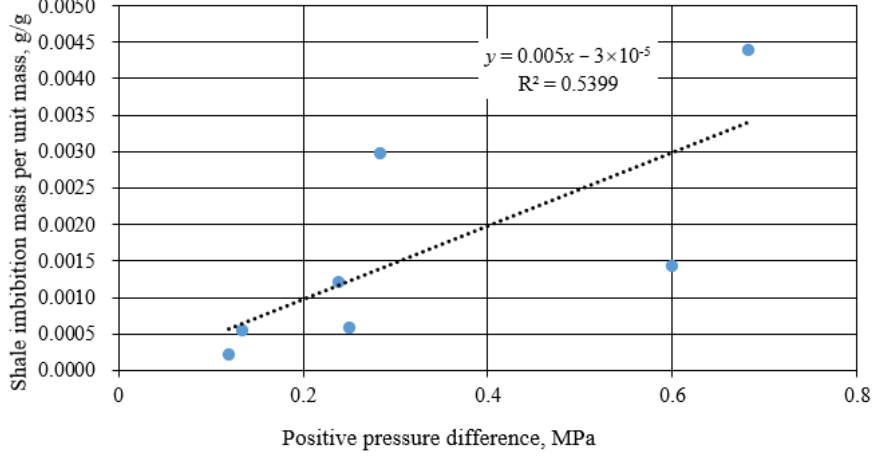
Figure 5. The relationship between positive pressure difference and shale imbibition mass per unit mass.